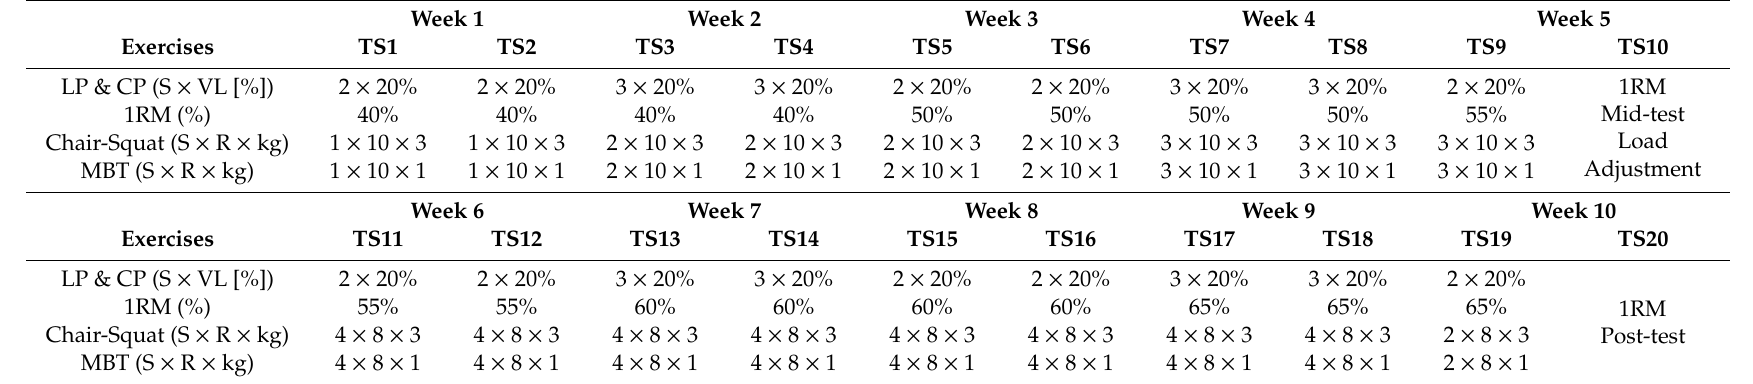
Table 2. Resistance training